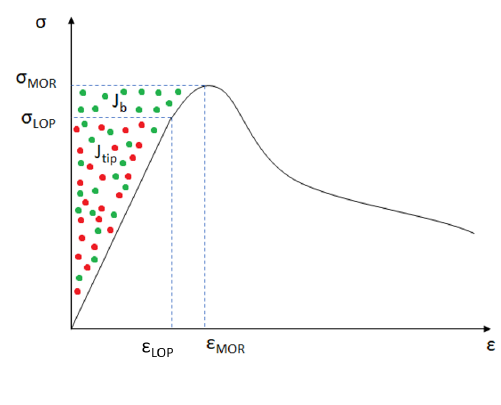
Figure 2. Typical crack mouth opening displacement (CMOD) curve with a representation of the calculated